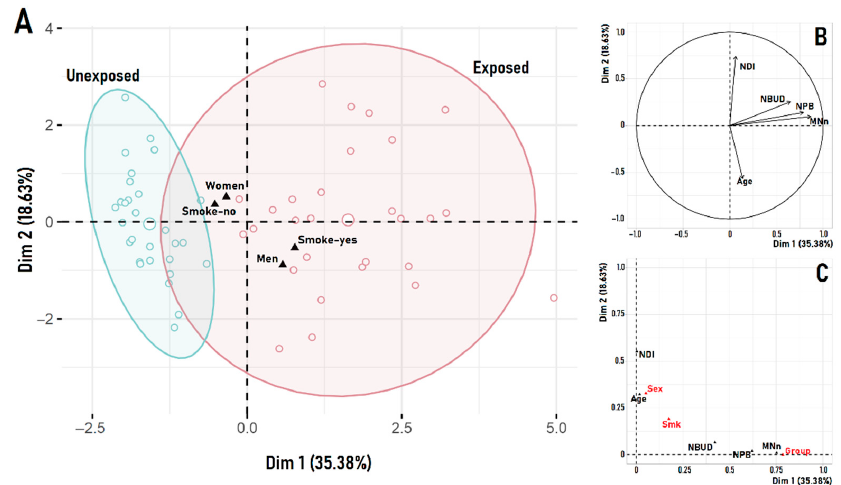
Figure 4. Results from the factor analysis of mixed data (FAMD). It shows the similarity relations between samples ( A ), the correlation circle for continuous variables ( B ) and the relation among all variables in the bidimensional space ( C ). Black triangles in ( A ) show the centroid for the respective group category. For the exposure groups variable, the red-blue ellipses denote the 95% confidence interval around the group (unexposed, exposed) centroid, which corresponds to the empty circle (slightly larger than the rest) within the respective ellipse. Red names in ( C ) correspond to categor- ical variables, while those in black represent continuous variables. MN: Micronucleus frequency; NDI: nuclear division index; NPB: nucleoplasmic bridge; NBUD: nuclear bud. 4. Discussion Pesticides are widely used in the world for pest control, especially in agriculture. Due to its high biological activity and its long persistence in the environment, many of these compounds affect non-targeted organisms, and humans are not the exception [2]. This occurs mainly through the occupational exposure to pesticides among workers involved in its manufacture, and users in the agricultural sector such as agricultural workers and professional pesticide applicators [44]. However, since the agricultural activity is trans- versal to human societies around the globe, there is great concern about the long-term impact of pesticides on human health. The results presented in this pilot study in the Maule region, Chile, showed that among the sampled population, the group of agricultural workers exhibit a high rate of genotoxic damage (MN, NPB, and NBUD frequencies) relative to their control. The results are consistent with other genotoxic studies conducted in Chile, but also from Latin Amer- ican [45] and other developing countries with a similar productive model and lack of reg- ulatory policies. For example, Kahl et al. [46] evaluated genotoxic damage in 121 tobacco field workers exposed to complex pesticides mixtures in Brazil. For this study, they used the Comet and Micronucleus assays, finding significantly increased DNA damage when comparing exposed and unexposed populations [46]. Another study conducted in Mexico,